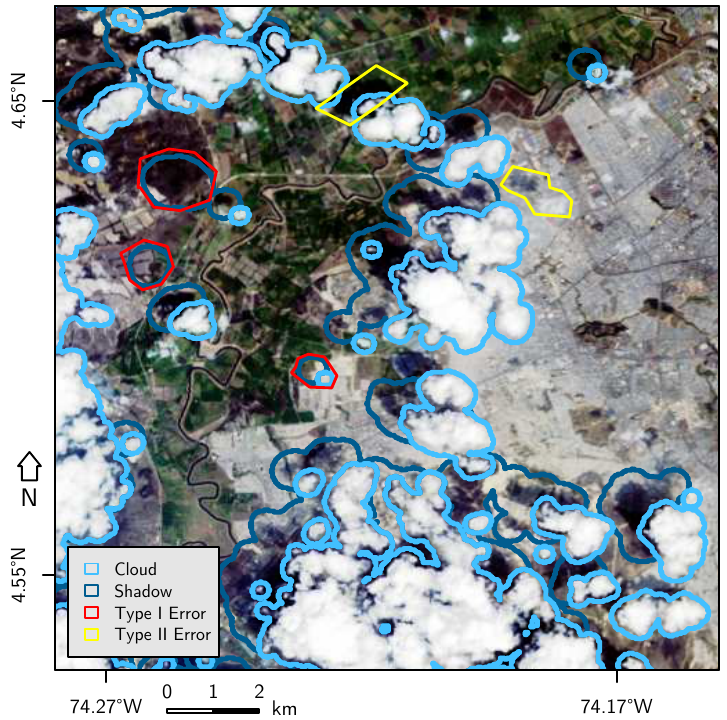
Figure 3. Landsat image depicting the Rio Bogotá and the transition between urbanized and agricultural areas within the Sabana de Bogotá . The image offers an example of a failed cloud detection and the corresponding shadow (yellow) and an erroneous cloud detection or cloud shadow classification (red) (data source: Landsat 23 January 2016 OLI RGB